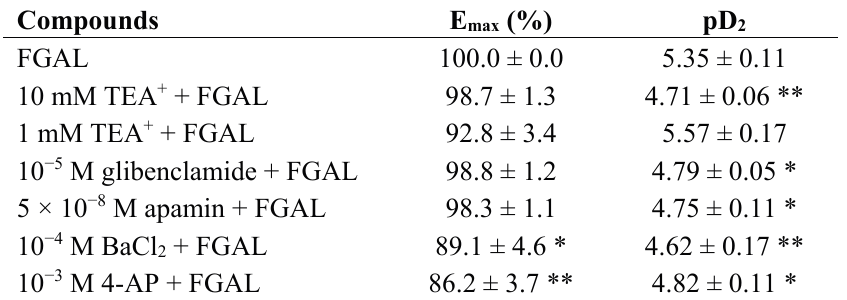
Table 2. E max (%) and pD 2 values of FGAL in both the absence and presence of K + channel blockers in rat aorta. Data are expressed as the mean ± S.E.M. ( n = 5). One-way